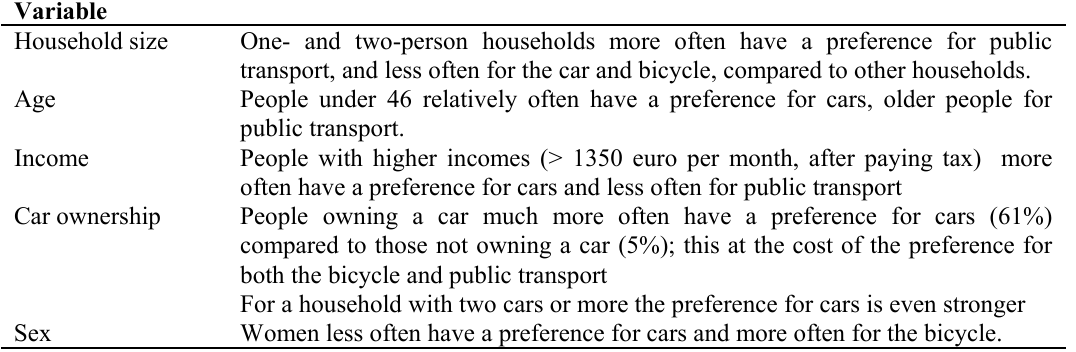
Table 5. Personal and household characteristics related to preferences for modes